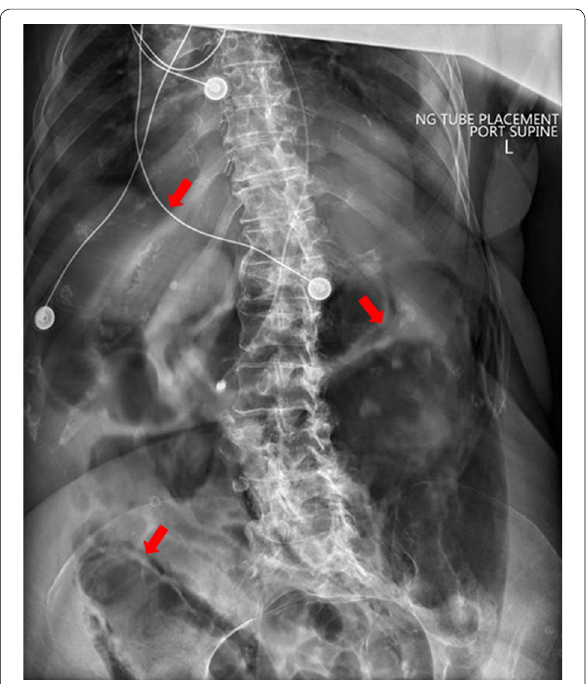
Fig. 2 Abdominal X-ray showing free intraperitoneal air due to a small bowl perforation. This image depicts suprahepatic accumulation of free air, which is considered a hallmark sign of pneumoperitoneum